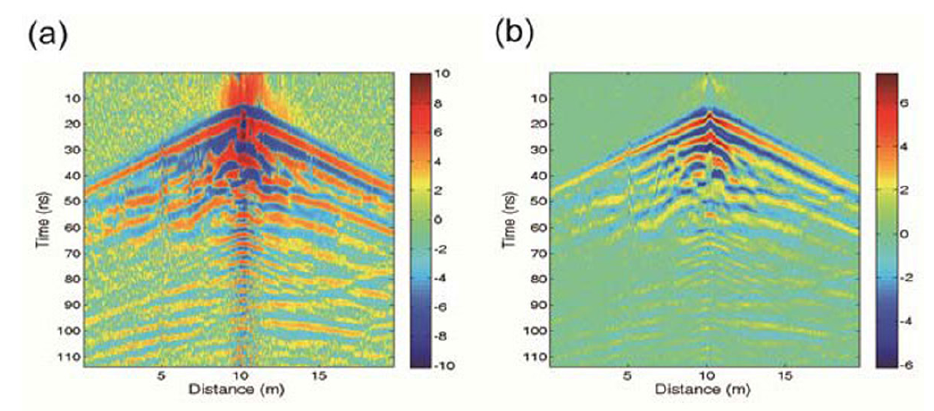
Fig. 13. GPR shot gather data after harmonic noise removal. (a) Result of applying the harmonic noise removing method without the aid of logarithmic transform. Components IMF-3 to IMF-5 were selected for reconstructing the data. (b) Result of applying the harmonic noise removing method to data with logarithmic transform data in which components IMF-3 to IMF-5 were selected for reconstructing the data. The amplitudes shown in both figures are on the logarithmic